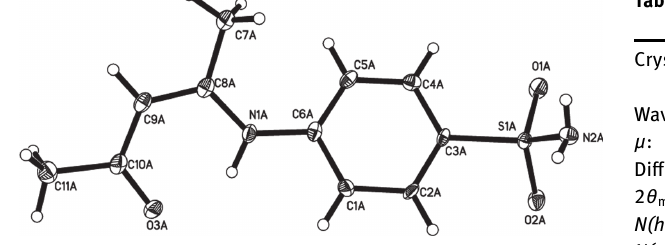
Table 1: Data collection and handling.